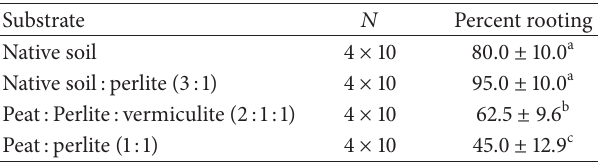
Table 7: The effect of substrate type on the rooting percentages of Calluna vulgaris heel cuttings harvested in March and planted outdoors. Mean values ± standard deviations. Groups that showed significant differences ( 𝑃 < 0.05 ) are indicated with different